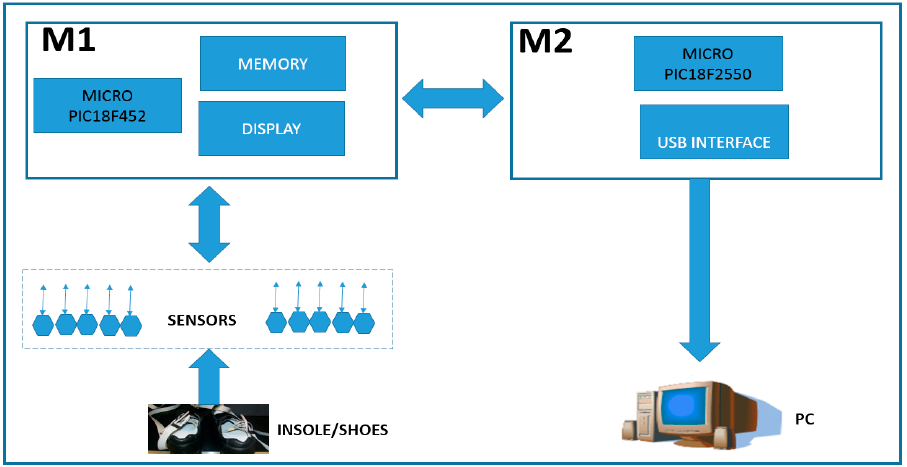
Figure 1. Block diagram of system architecture of portable system for monitoring the footwear-foot microclimate, showing the logical configuration of sensors, microprocessor, memory, USB interface, and PC.